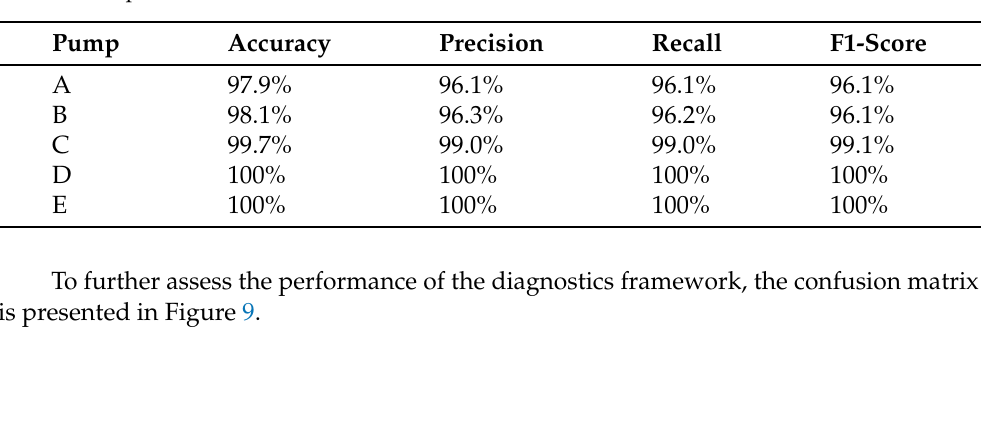
Table 5. FDI performance evaluation of